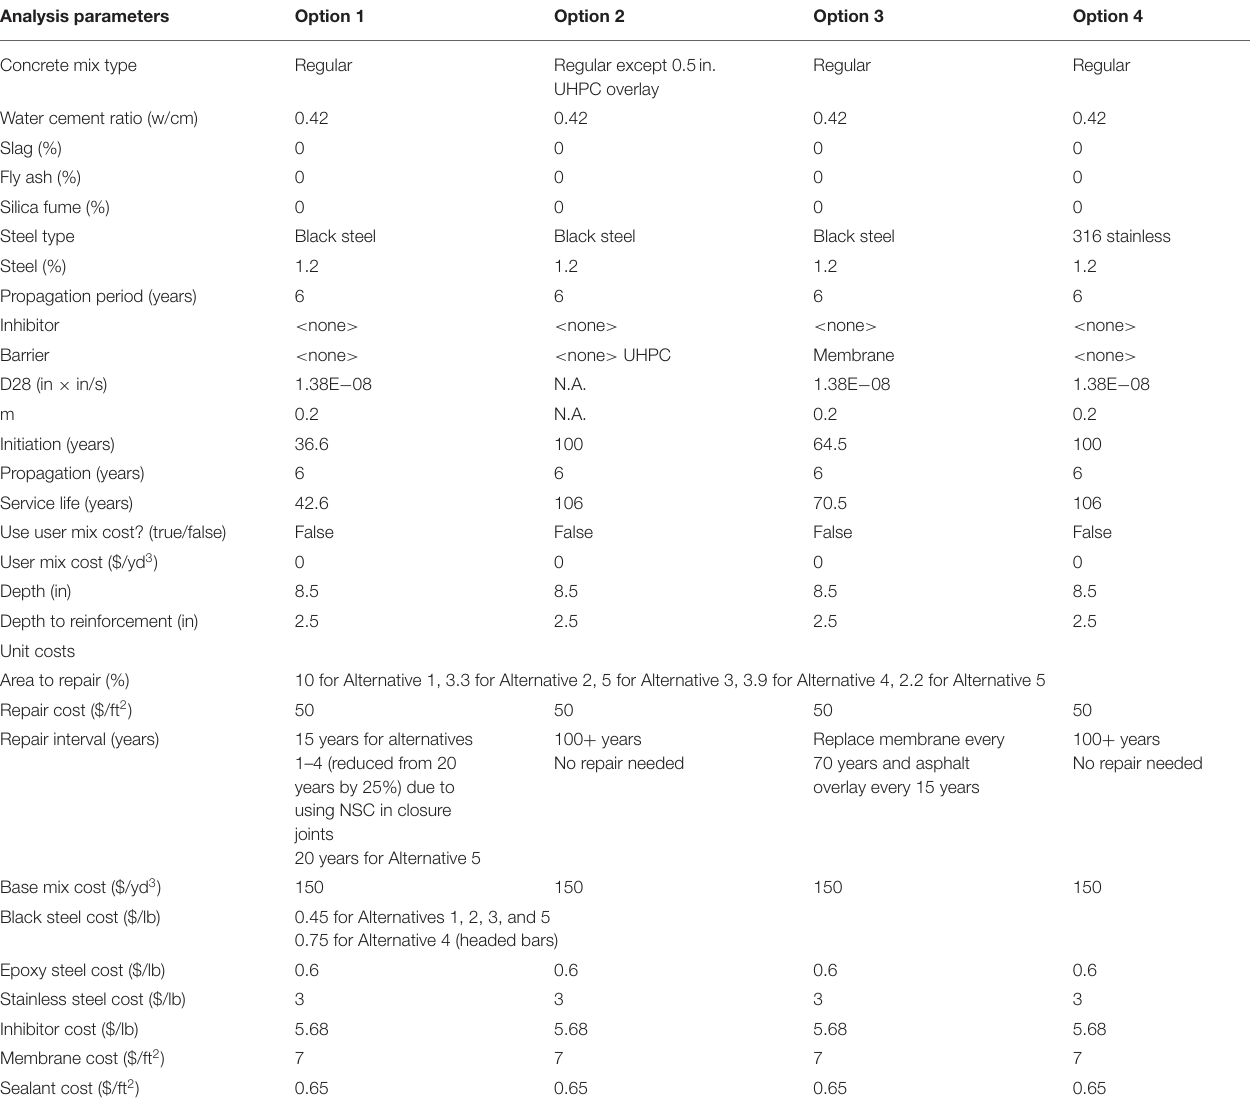
TABLE 6 | Parameters in Life-365 specific to each alternative and